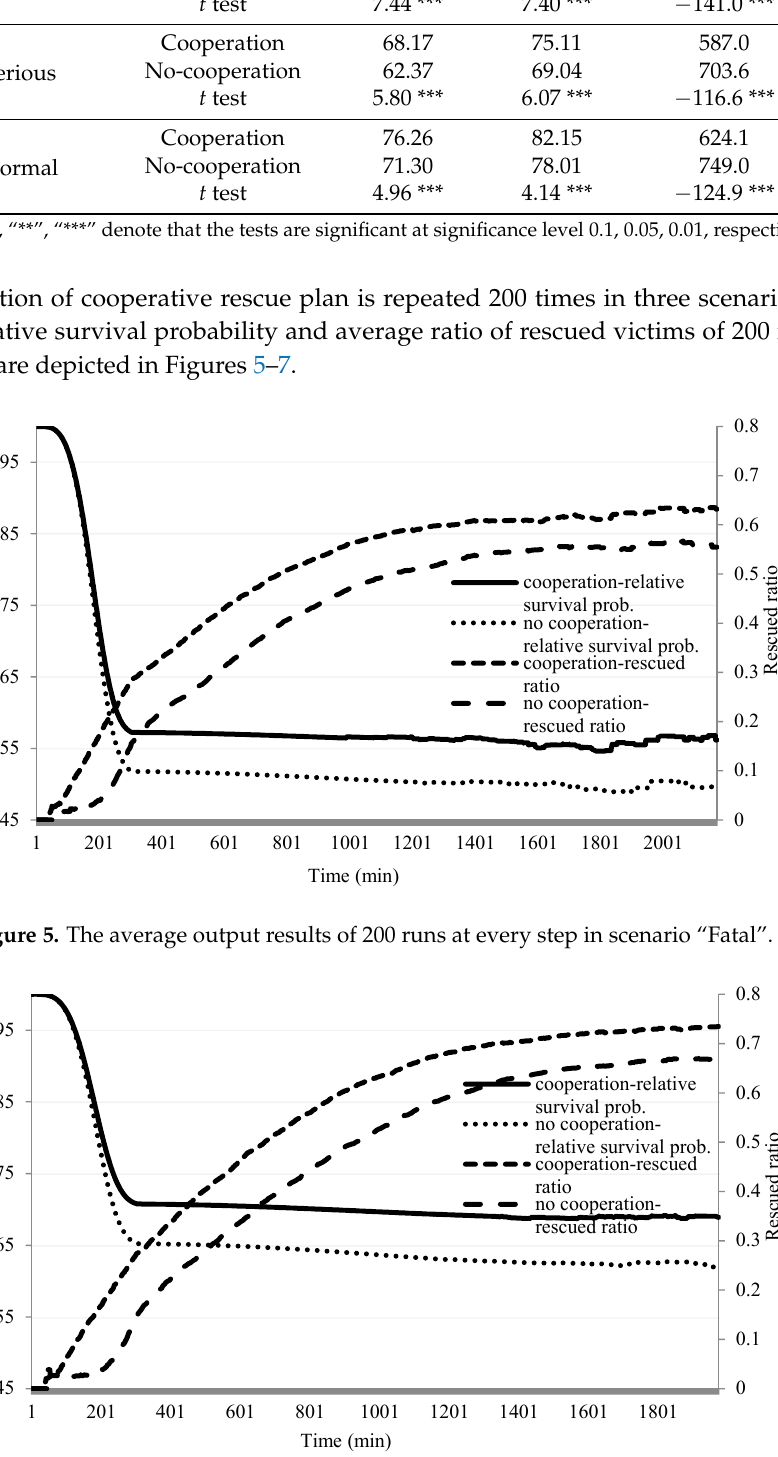
Figure 7. The average output results of 200 runs at every step in scenario “Normal”. The simulation results indicate that the cooperative rescue plan would improve the rescue result a lot, compared with the non-cooperative rescue plan. In the above three scenarios, it increases victims’ relative survival probability by 7–15%, increases the ratio of survivors getting rescued by